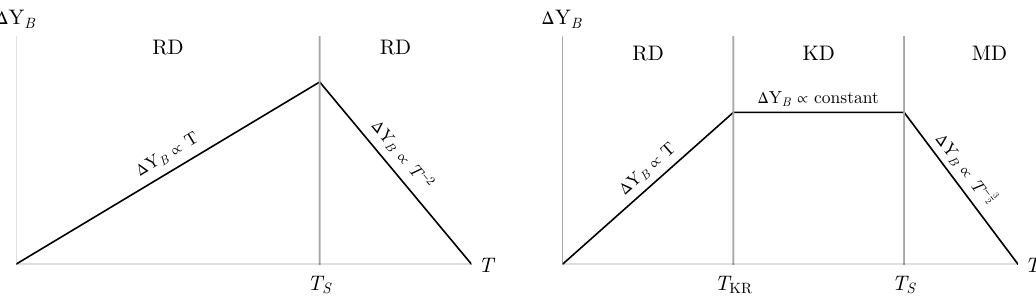
Figure 3 . The baryon asymmetry produced per Hubble time ∆ Y B as a function of temperature T in log-log scales during radiation-dominated, kination-dominated, and matter-dominated